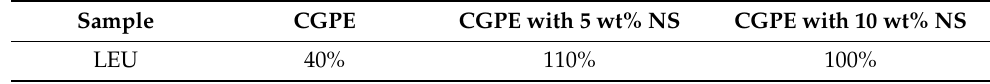
Table 1. LEU values of the different CGPEs.